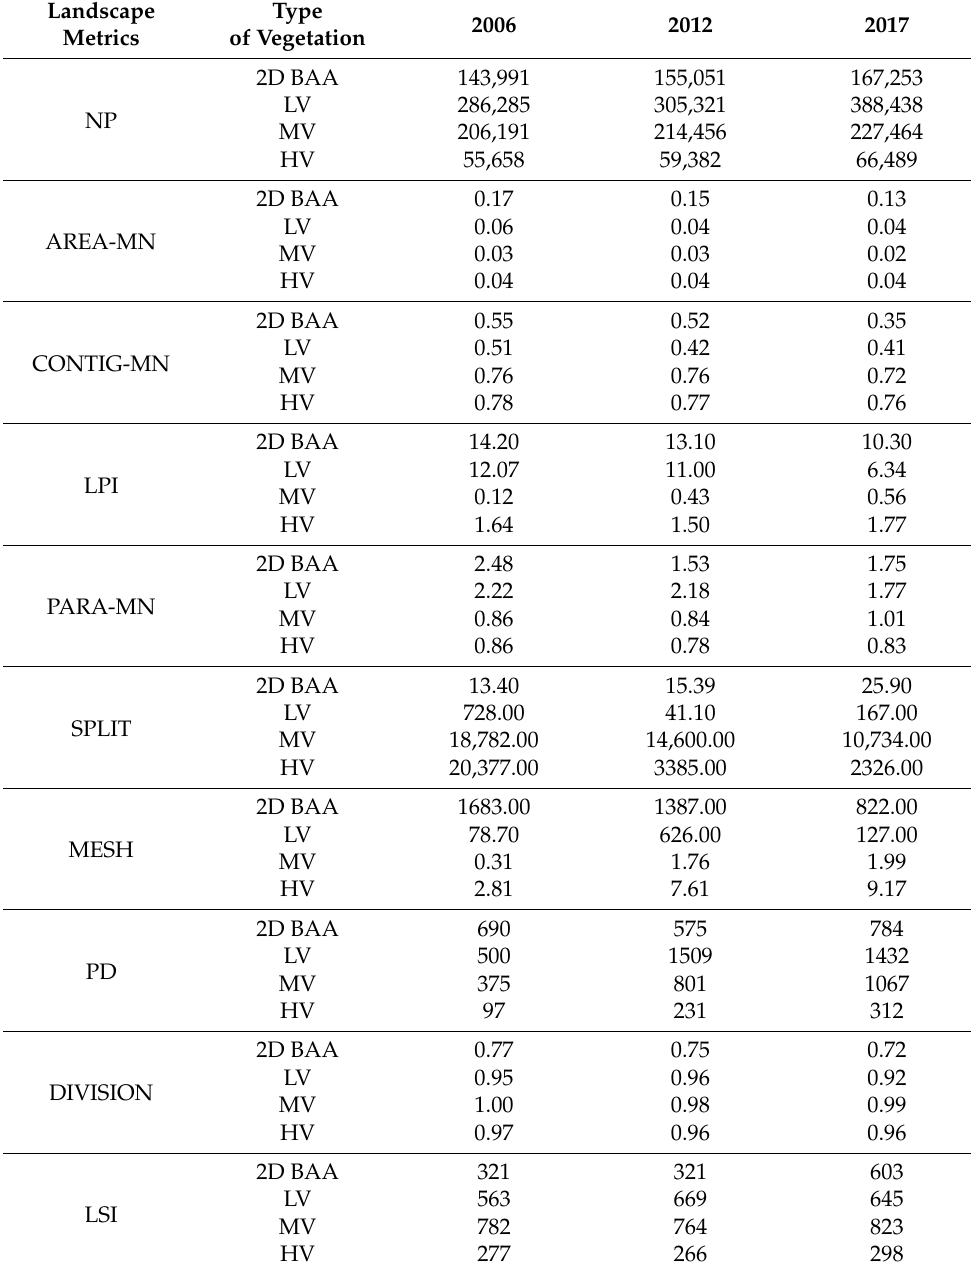
Table 5. Landscape metrics calculated for Krakow UF for 2006, 2012, and 2017. Landscape Type Metrics of